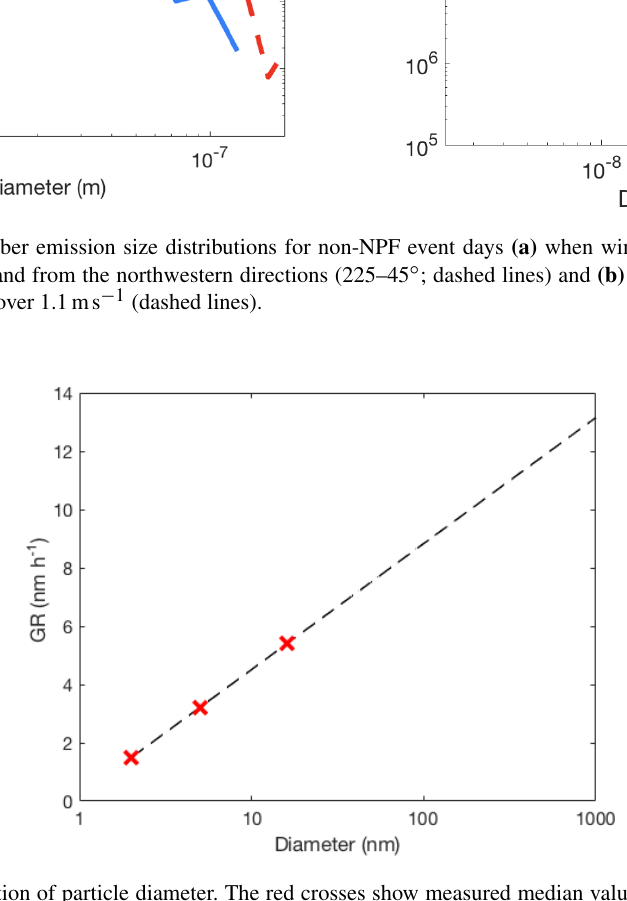
Figure A6. Particle GR as a function of particle diameter. The red crosses show measured median values based on Zhou et al. (2020), and the black line is a fit to the measured